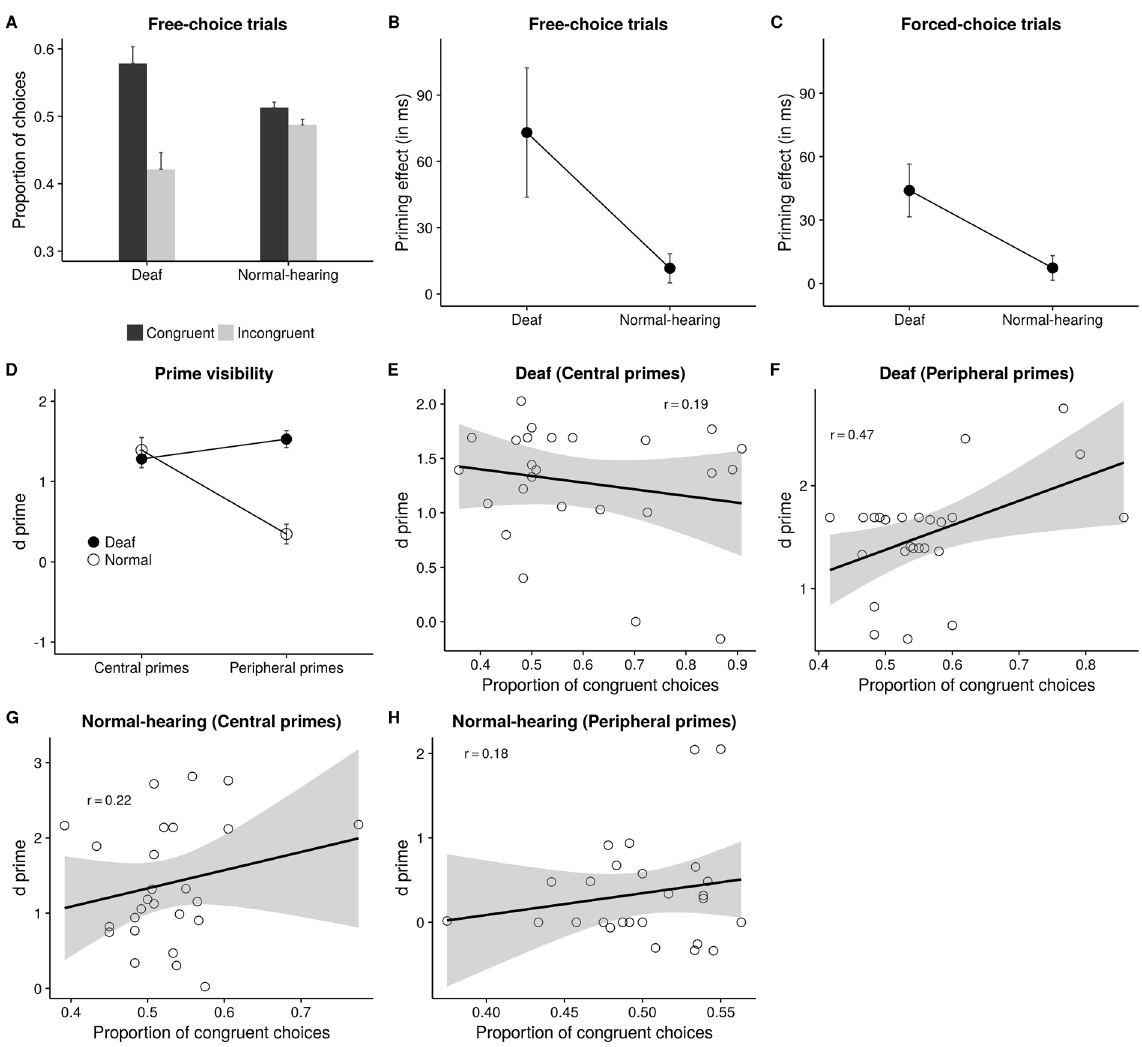
Figure 2. Experiment 1 results. ( A ) Deaf made more congruent choices on free-choice trials compared to normal-hearing. The RT priming effect (RT incongruent – RT congruent) is larger for the Deaf on both free- choice ( B ) and forced-choice ( C ) trials. ( D ) Deaf are better at discriminating primes, only at periphery. ( E – H ) Plots of correlation between proportion of congruent choices at the two prime locations for the two groups. The effect was significant ( p = 0.02) only for the Deaf at periphery ( F